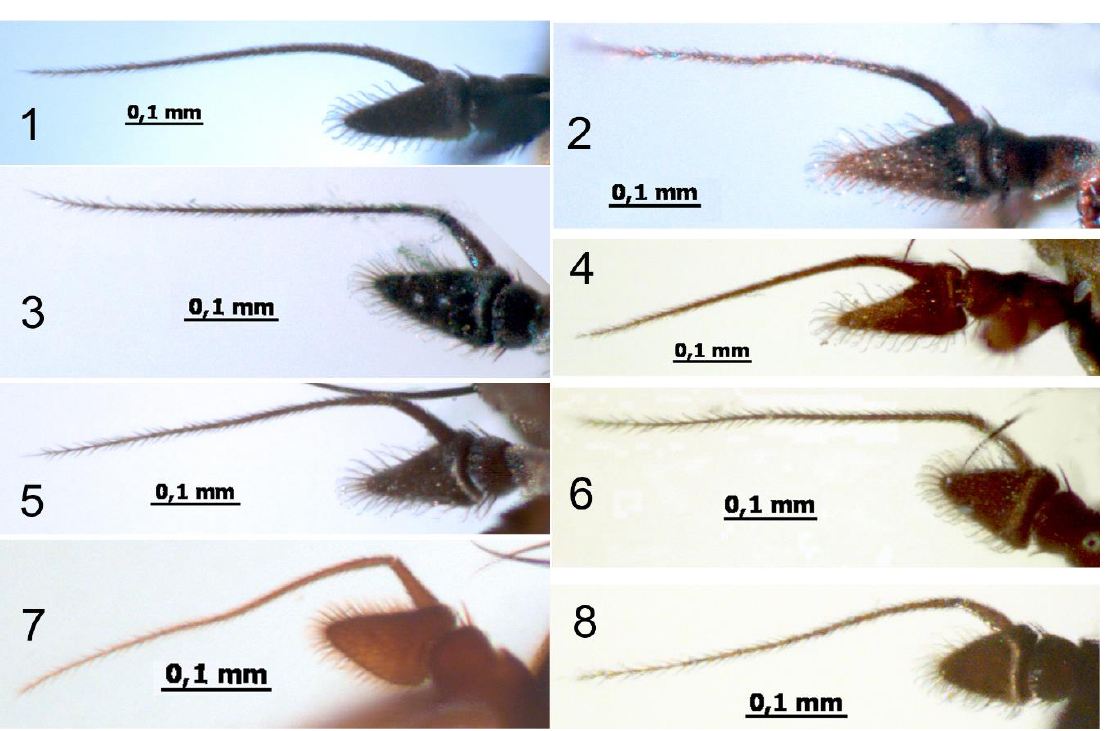
Figs 1–8. Campsicnemus sp., male antenna. Figs 1, 4. C. armatus (Zetterstedt): 1 — Russia: Solovetskie Islands; 4 — Russia: NE Yakutia. Figs 2, 3, 5. C. vtorovi Negrobov et Zlobin: 2 — Russia: Voronezh Region; 3 — Russia: Ulyanovsk Region; 5